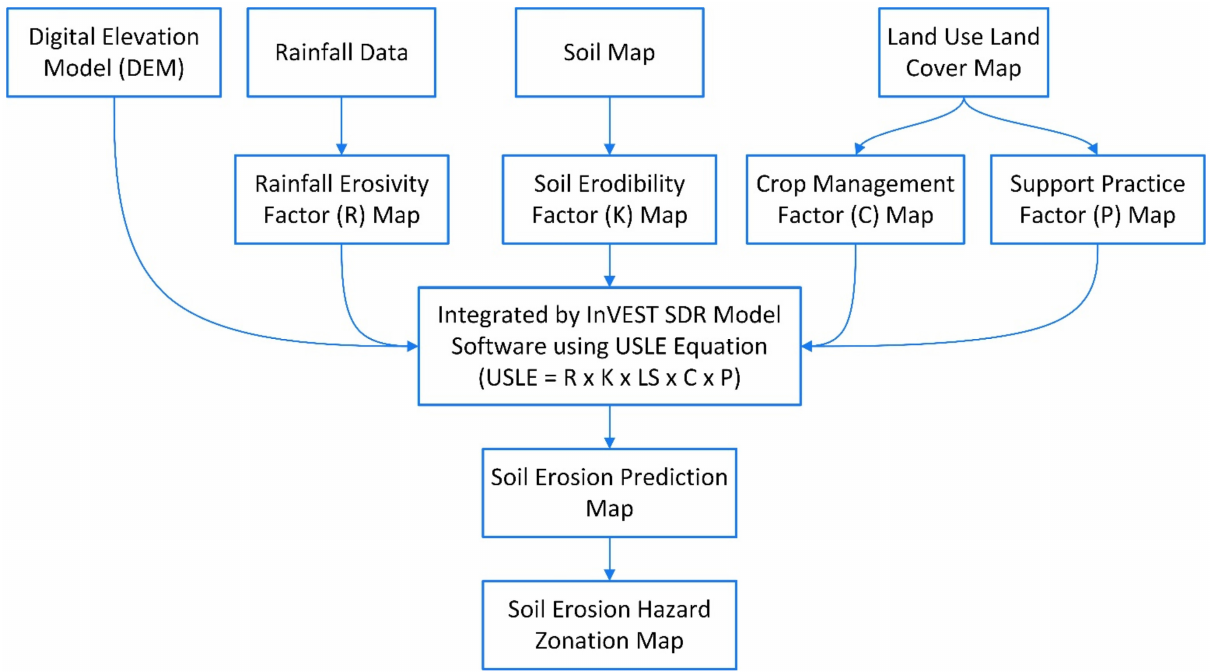
Figure 2. Graphical illustration of the theory behind running the InVEST SDR